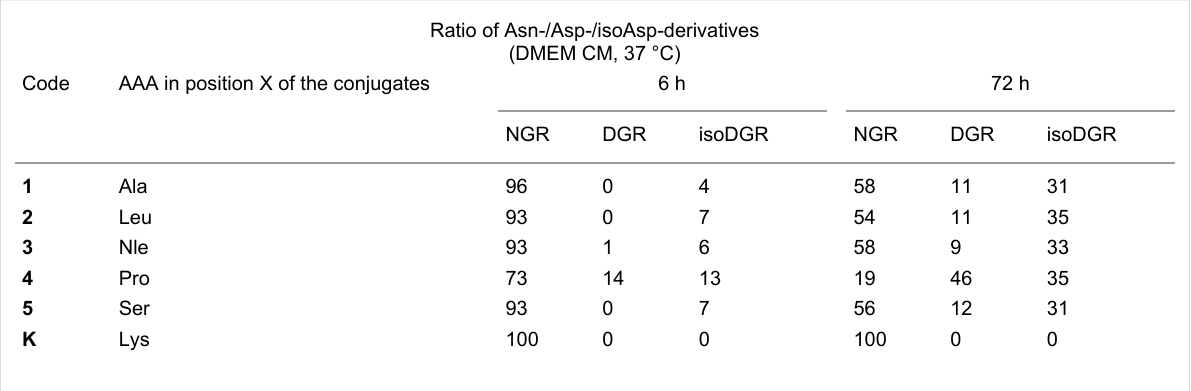
Table 2: Chemostability of cyclic NGR peptide-Daunomycin conjugates.